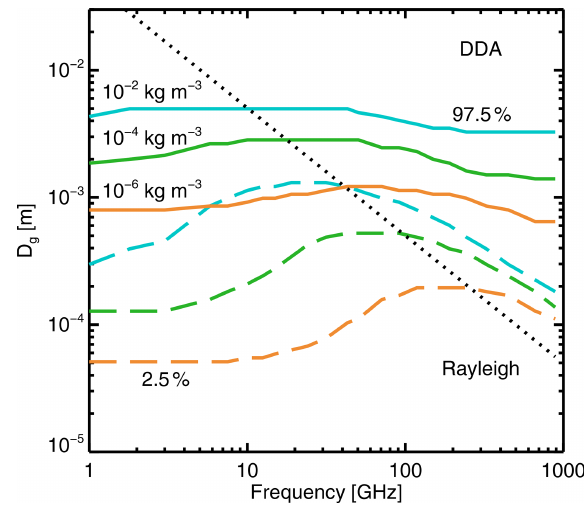
Figure 7. 2.5 (dashed) and 97.5 (solid) percentiles of contributions to the integration of bulk extinction (the “extagrand” in Fig. 6c and d) for the ARTS ICON hail particle and the F07 T PSD. These are shown as a function of frequency; other aspects of the integration are as Fig. 6. Water contents are coloured as indicated in the legend. The dashed black line indicates the limit of the Rayleigh regime for this particle; above this, non-spherical optical properties must be computed using DDA or equivalent